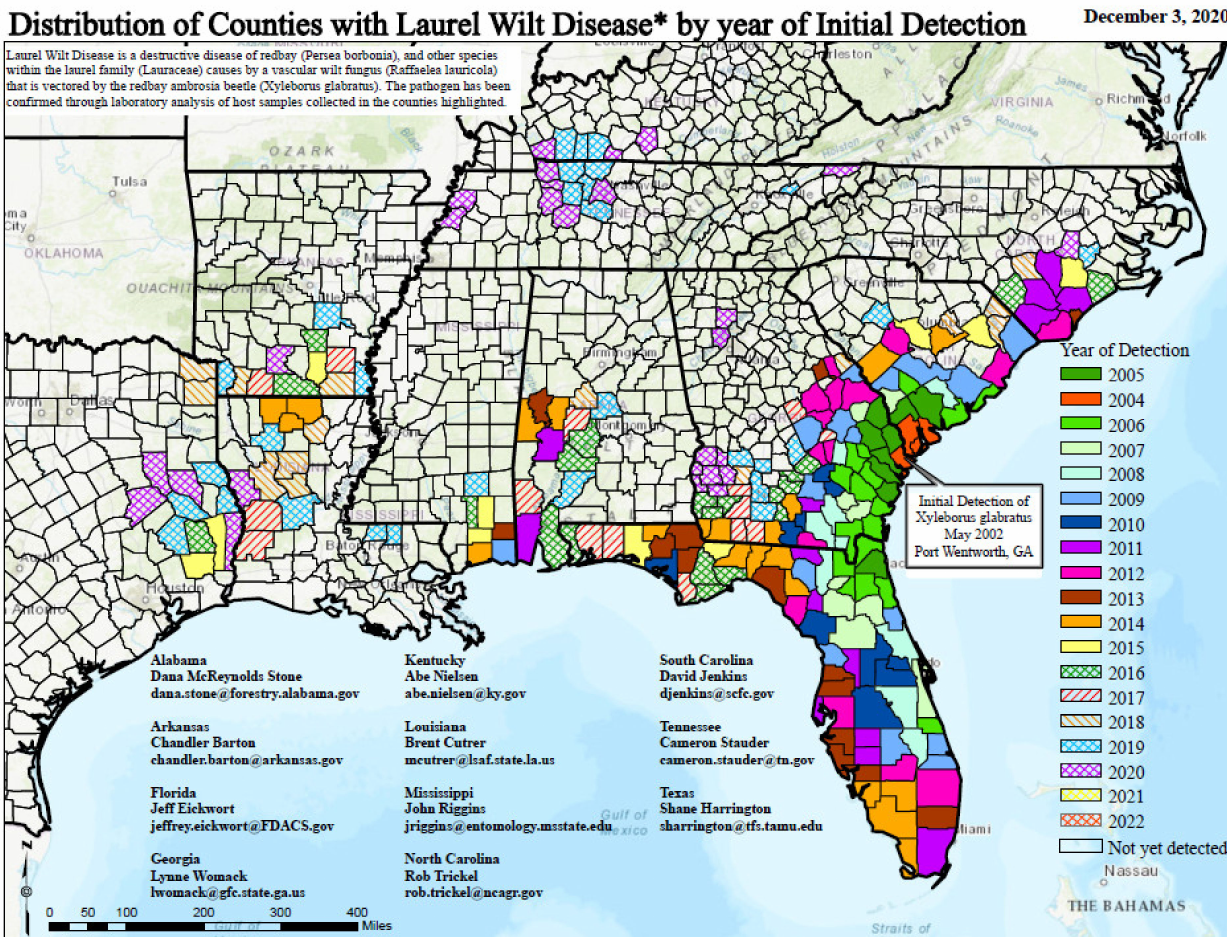
Figure 2. Distribution of counties with laurel wilt by year of initial detection updated 3 December 2020. (Available online: https://www.fs.usda.gov/main/r8/forest-grasslandhealth accessed on 29 January